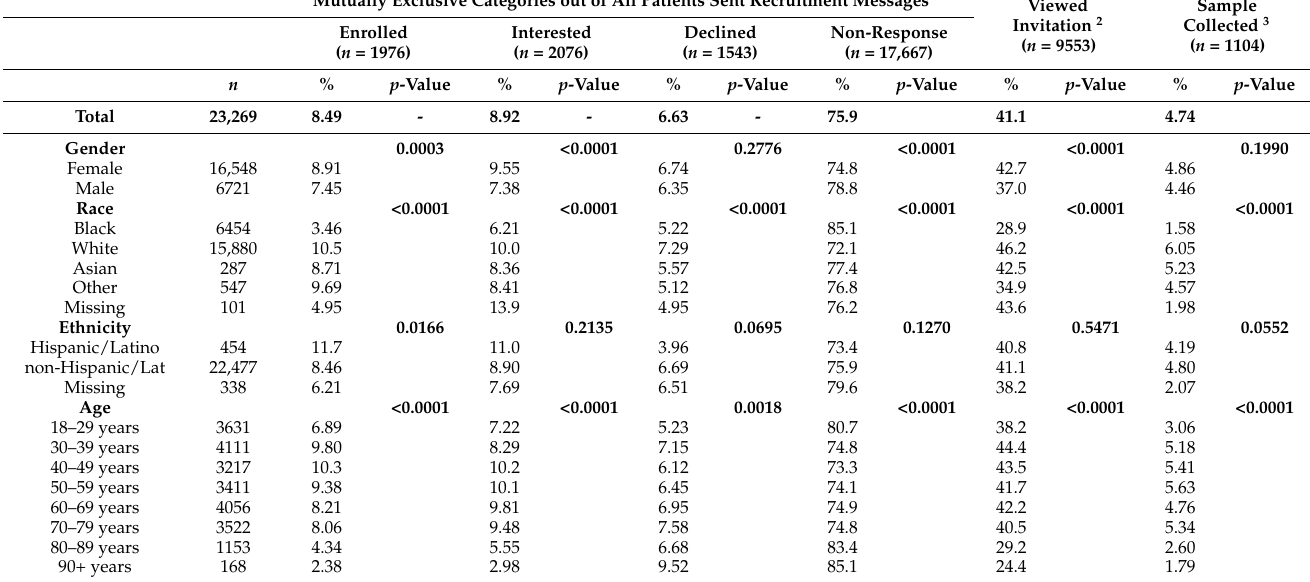
Table 2. Response rates for the enrolled, interested, declined, identified, viewed invitation, and sample collected groups out of all patients invited to participate in the total population and stratified by demographic